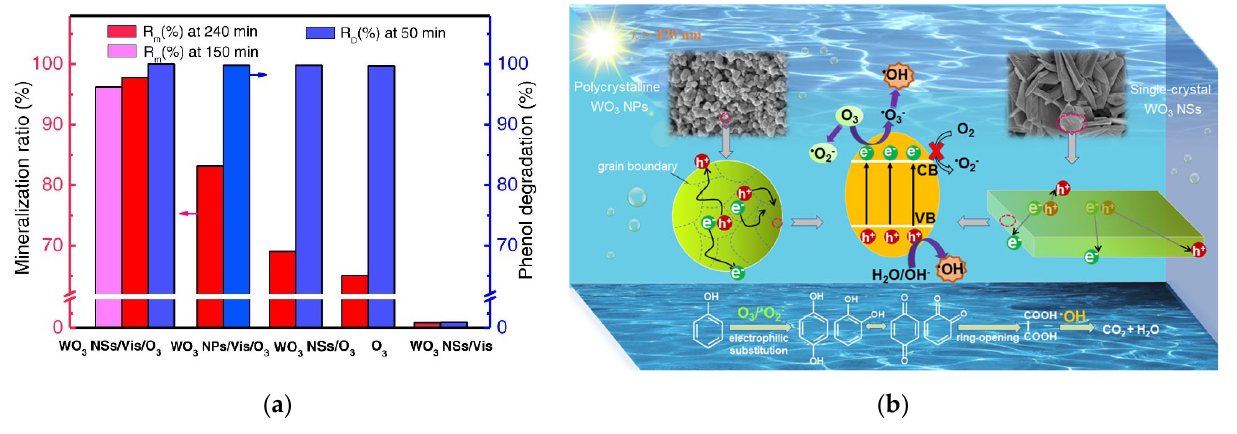
Figure 14. ( a ) Mineralization ratio (R m ) and degradation efficiency (R D ) of phenol in various oxida- tion processes; ( b ) Proposed mechanism of phenol mineralization in WO 3 nanosheets under visible light irradiation. Reproduced with permission from ref. [111]. Copyright 2022 Elsevier.